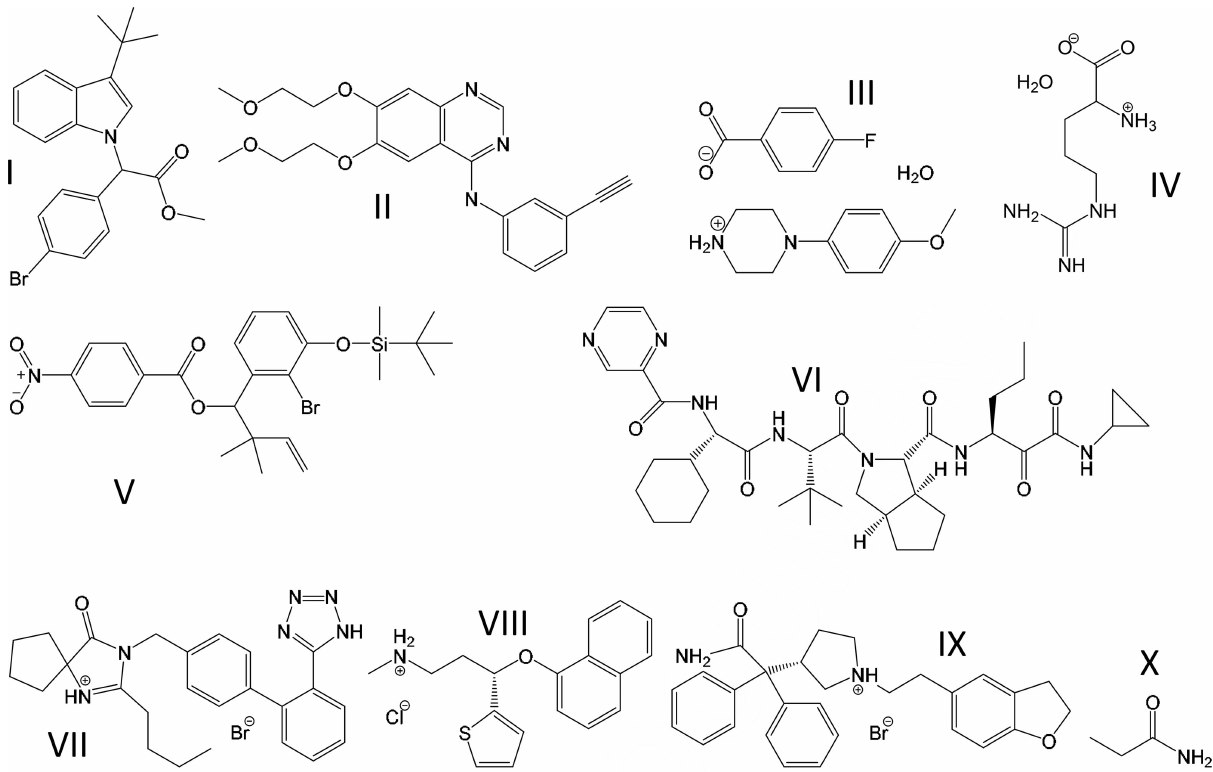
Figure 1 Molecules used for studying disorder in this work, ordered by CSD refcode: I , methyl (4-bromophenyl)(3- tert -butyl-1 H -indol-1-yl)acetate; II , erlotinib; III , a cocrystal of MeOPP with 4-fluorobenzoate and H 2 O; IV , DL-arginine monohydrate; V , 1-(2-bromo-3-{[ tert -butyl(dimethyl)silyl]oxy} phenyl)-2,2- dimethylbut-3-en-1-yl-4-nitrobenzoate; VI , telaprevir; VII , irbesartan HBr 2H 2 O; VIII , duloxetine HCl; IX , darifenacin HBr; and X , Birger Dittrich (cid:2) Modelling disordered crystal structures and distinguishing disorder